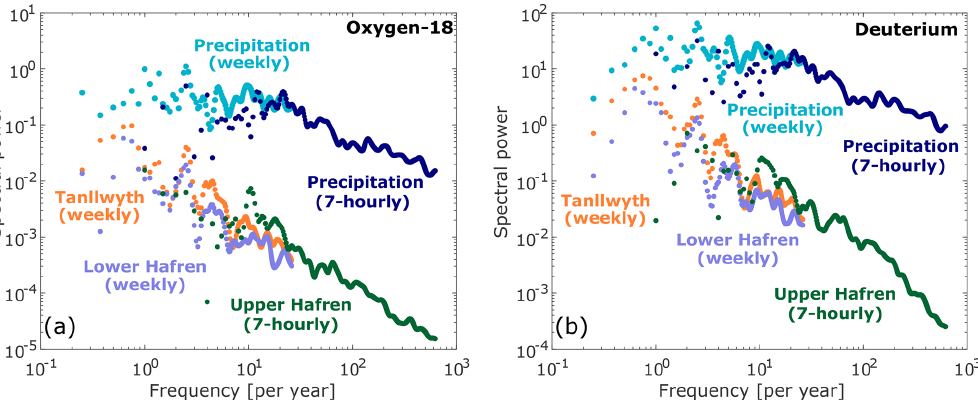
Figure 7. Power spectra of fluctuations in oxygen-18 (a) and deuterium (b) in precipitation and streamwater, calculated using the weighted wavelet and alias filtering methods of Kirchner (2005) and Kirchner and Neal (2013). Weekly and 7-hourly streamwater spectra are not strictly comparable because they are measured in different streams, whereas weekly and 7-hourly precipitation spectra were calculated from samples collected at the same location (although during partly non-overlapping time